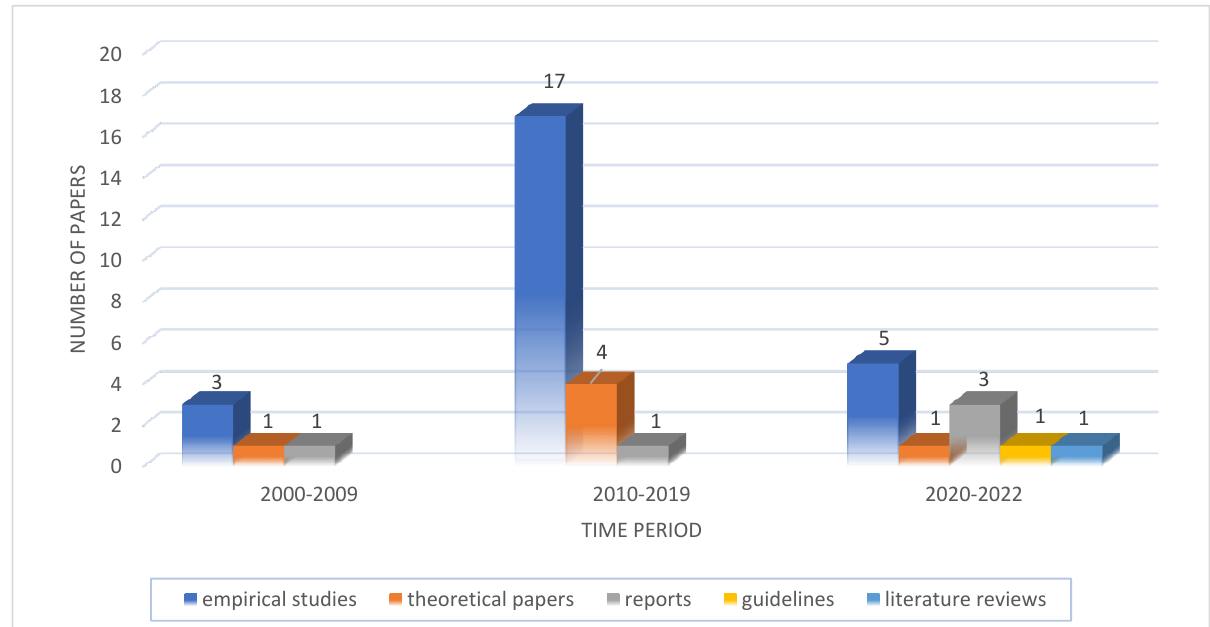
Figure 2. Distribution of studies per type and publication period.